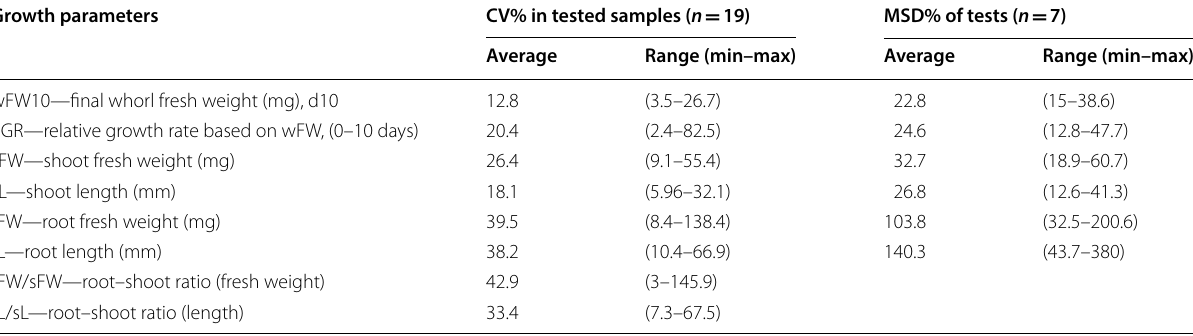
Standard growth parameter according to ISO 16191